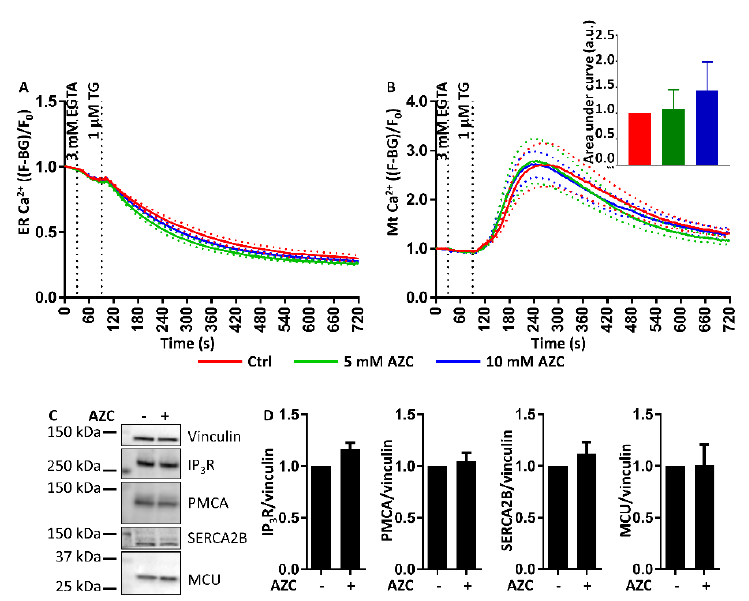
Figure 9. AZC does not affect the ER store content or ER-mitochondrial Ca 2+ transfer. Cells were transfected with the Ca 2+ sensors G-CEPIA1 er and R-GECO1 mt . At 48 h after transfection, cells were pretreated with 5 mM or 10 mM AZC for 6 h. Extracellular Ca 2+ was chelated with 3 mM EGTA and 60 s later ER Ca 2+ release was uncovered with 1 μM thapsigargin (TG) as indicated. At least 99 cells in six independent experiments were measured and results are shown as mean ± SEM (indicated by the dotted lines). ( A ) AZC pretreatment did not change the properties of the ER Ca 2+ store as detected by G-CEPIA1 er . ( B ) AZC pretreatment did not affect uptake by the mitochondria of ER-released Ca 2+ as detected by R-GECO1 mt. The insert shows the quantification of the area under the curve of traces showing Ca 2+ uptake by the mitochondria. ( C ) AZC treatment does not affect the expression levels of the IP 3 Rs, the plasma membrane Ca 2+ ATPases (PMCA), SERCA2B or the mitochondrial Ca 2+ uniporter (MCU). A representative blot of eight independent experiments each performed in duplicate is shown. Vinculin was used as loading control. ( D ) Quantification of protein levels in ( C ) shown as mean ± SEM relative to untreated control.